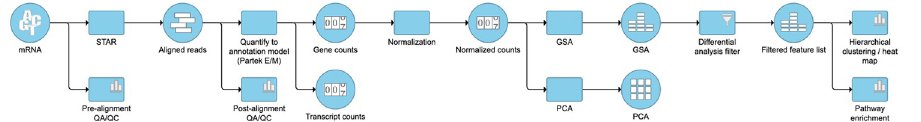
Fig 1. Schematic of workflow within Partek. Blue boxes, processes as indicated. Blue circles, data types as